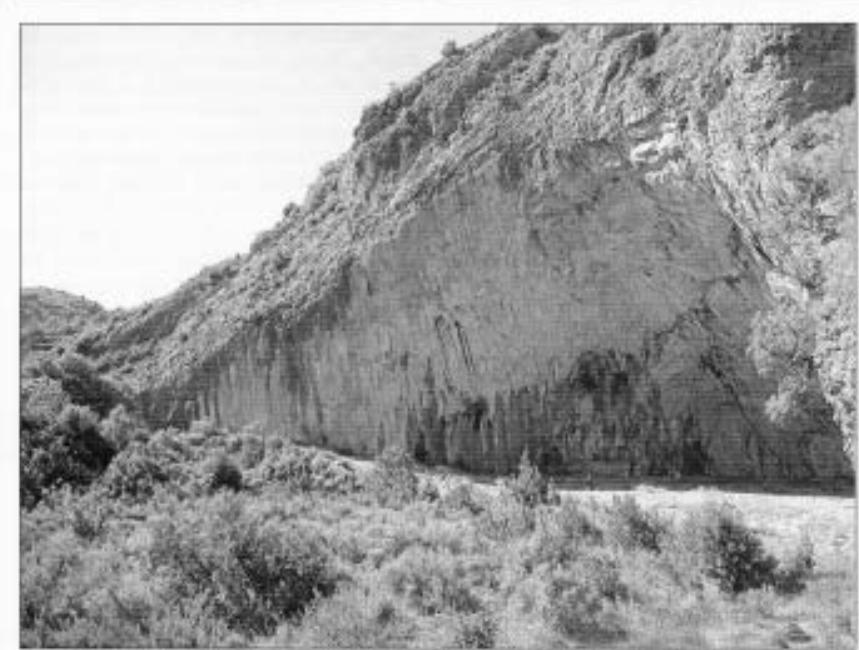
Figure 6 The Cava Gran rockshelter in Lleida region, a few kilometres away from La Roca dels